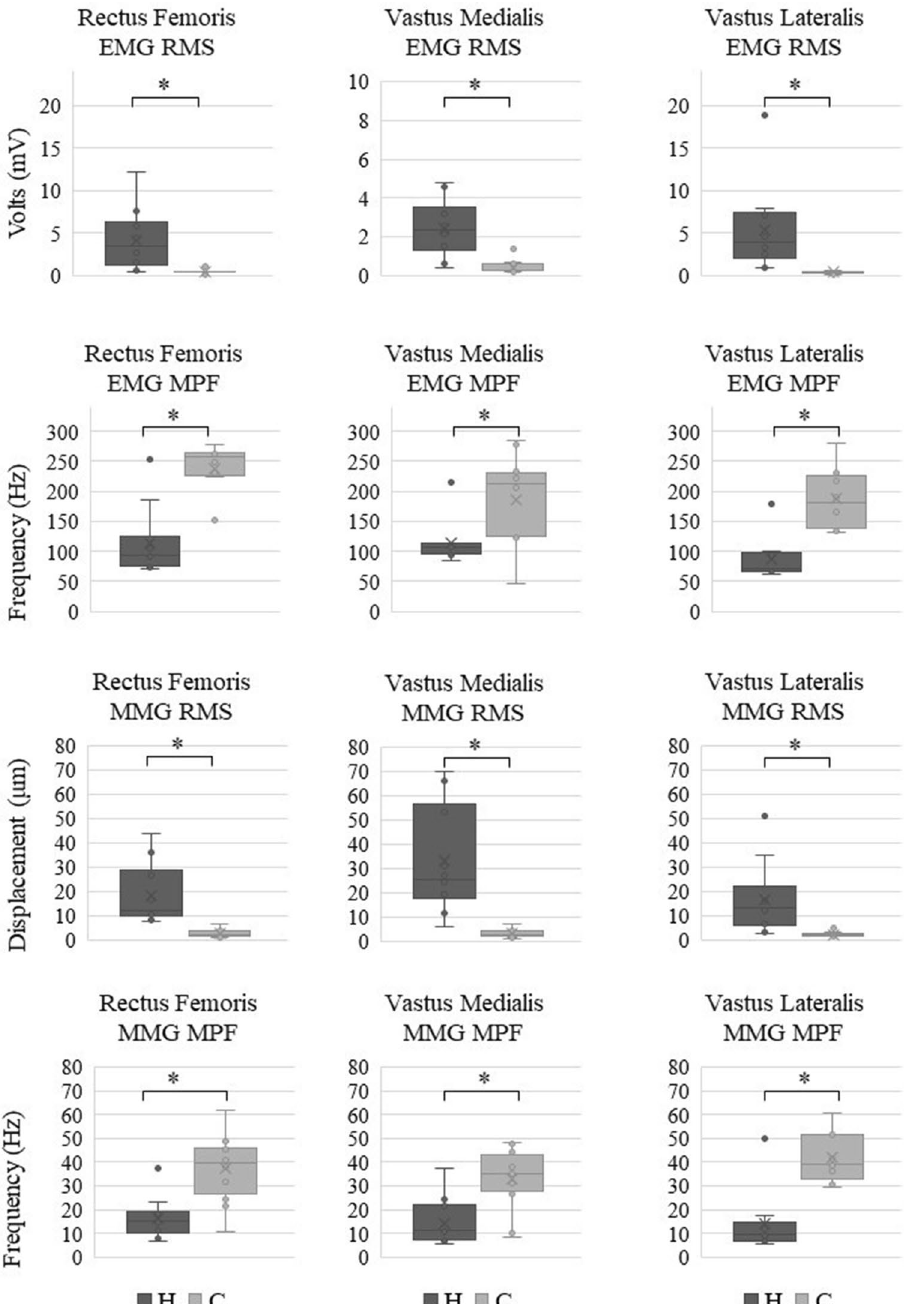
Figure 2. Differences between participants with hyperreflexia (H group) and control participants (C group) for EMG–RMS, EMG–MPF, MMG–RMS, and MMG–MPF with a constant force. The H group is shown on the left side, and the C group is shown on the right side of each graph. Standard deviation is shown as an error bar. The asterisk indicates p < 0.001. EMG: electromyography, RMS: root mean square, MMG: mechanomyography, MPF: mean power